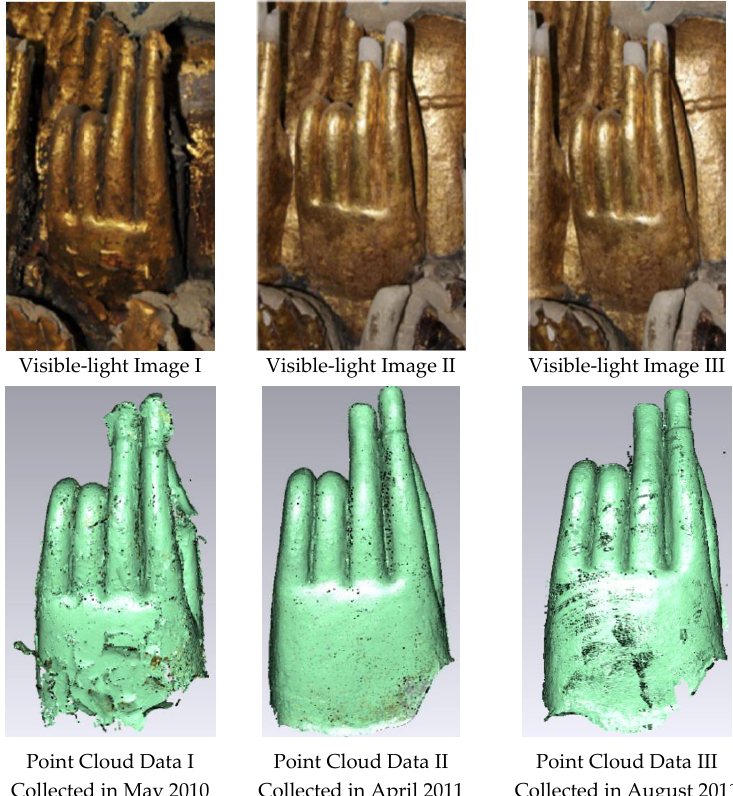
Figure 12. The position of hand 9-10-S2 on the statue. ISPRS Int. J. Geo-Inf. 2016 , 5 , 60